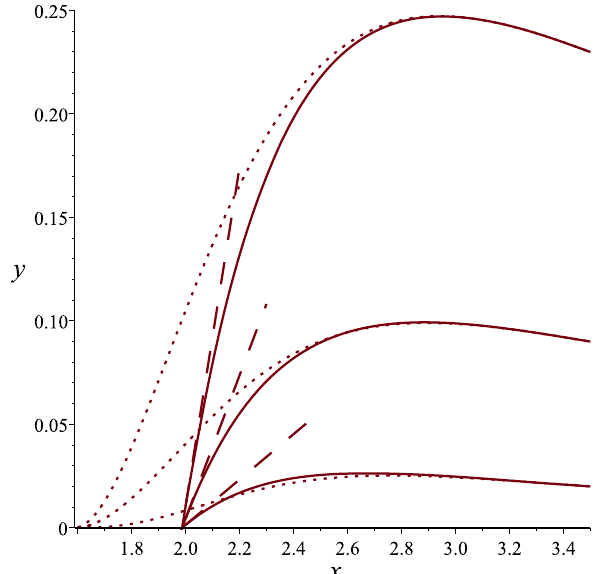
Fig. 4 Comparisonoftheapproximateform(21)oftheeffectivepoten- tial (dashed lines) close to the event horizon in the extreme case with the exact form of U ef f (solid lines) given by (9) for different values of the angular momentum ( (cid:3) = 0 bottom, (cid:3) = 1 middle, (cid:3) = 2 upper curves). The plot has been generated by expressing (21) in terms of the variable x with the help of (16). The dotted lines represent the effective potential in the extreme case. Note the change in concavity at the event horizons for the effective potentials in the extreme and nonextreme cases. This behaviour signalizes that the approximation (21) breaks down in the extreme case and it should be replaced by (22) as in Fig. 5. The label on the y-axis refers to the effective potential